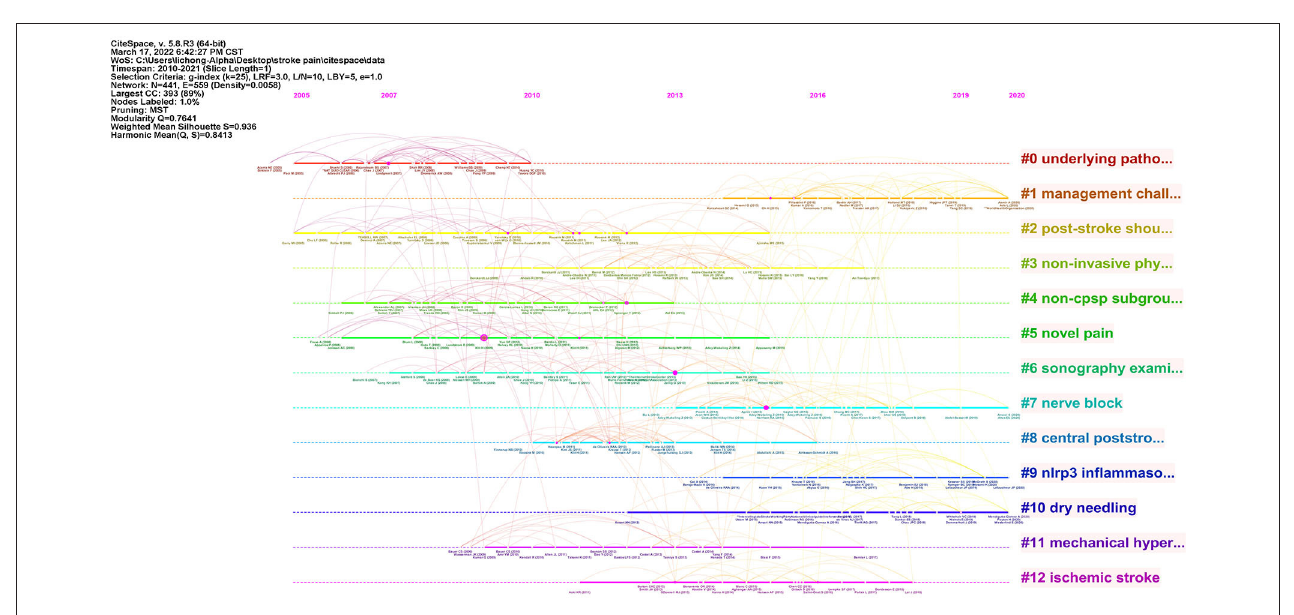
FIGURE 6 | A timeline view of reference co-citation